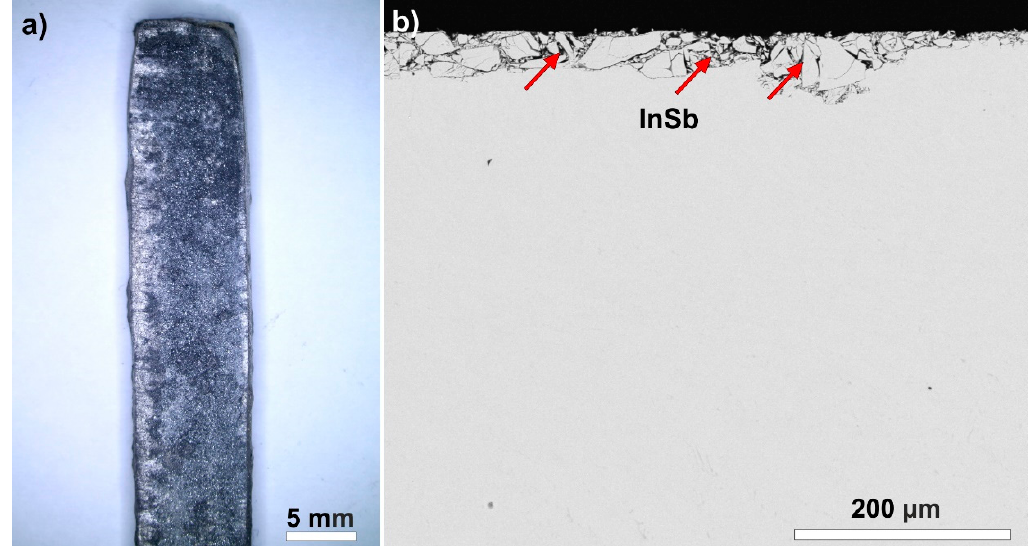
Figure 2. Optical micrographs of the sample: ( a ) the surface of a sample after the application of InSb; ( b ) penetration of InSb into the sample body.